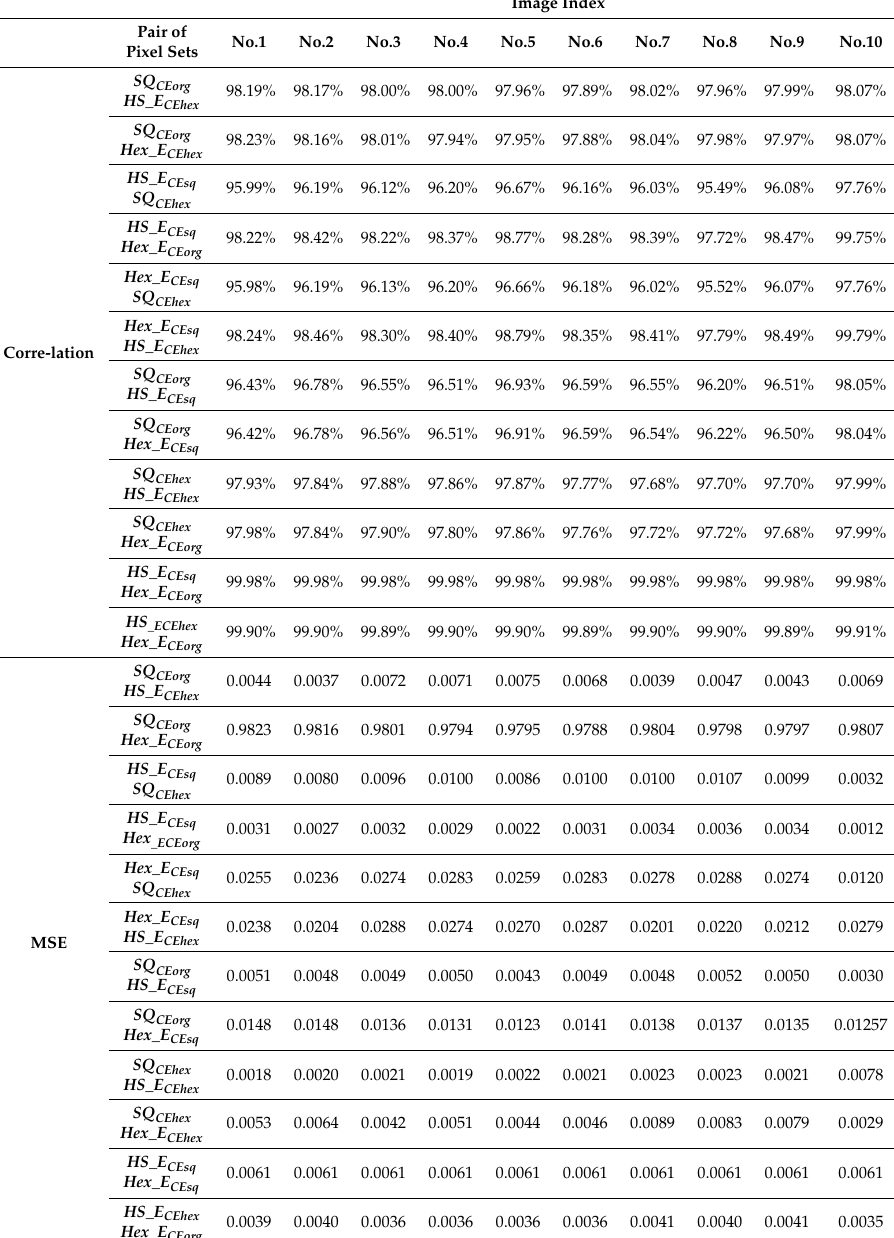
Table 4. Assessment by comparison of the pixel sets on different arrangements via two types of common